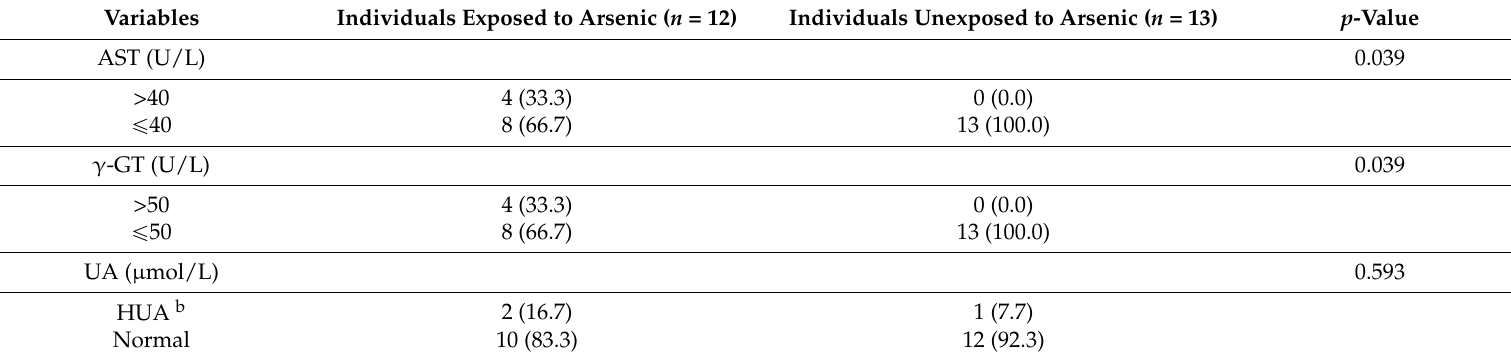
Table 3. Distribution of high AST, γ -GT and UA levels between family members who were exposed and unexposed to arsenic a .